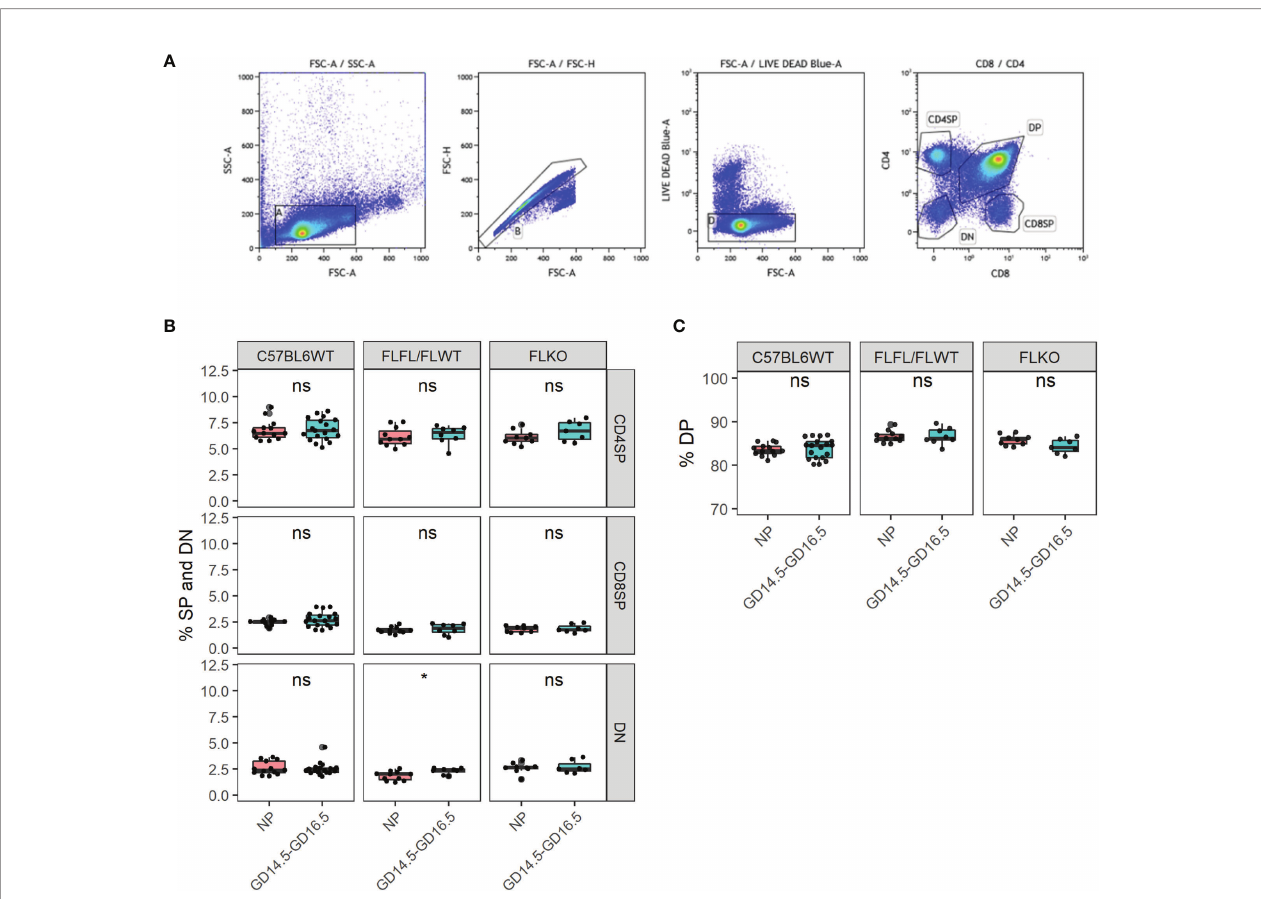
FIGURE 5 | Thymocyte developmental process is undisrupted in the thymus of Pgr d/d in pregnancy. (A) Gating strategy of the murine thymus for CD4SP, CD8SP, DN, and DP. (B) % CD4 single positive (SP), CD8SP and DN in WT, FLFL/FLWT and FLKO between NP and GD14.5-GD16.5 of pregnancy. (C) % DP population in WT, FLFL/FLWT and FLKO between NP and GD14.5-GD16.5 of pregnancy. Student ’ s t-test, *p < 0.05, ns, not signi fi cant. Each dot represents one